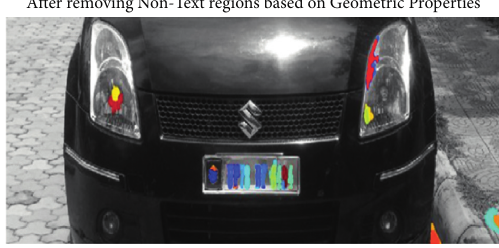
Figure 13: MSER blobs filtered using the geometric property.